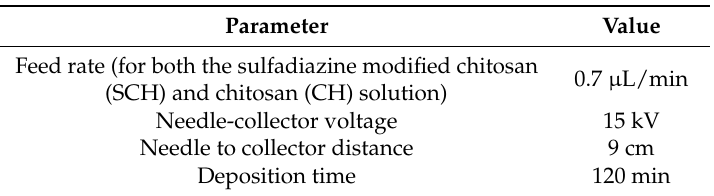
Table 1. Optima electrospinning parameters used.